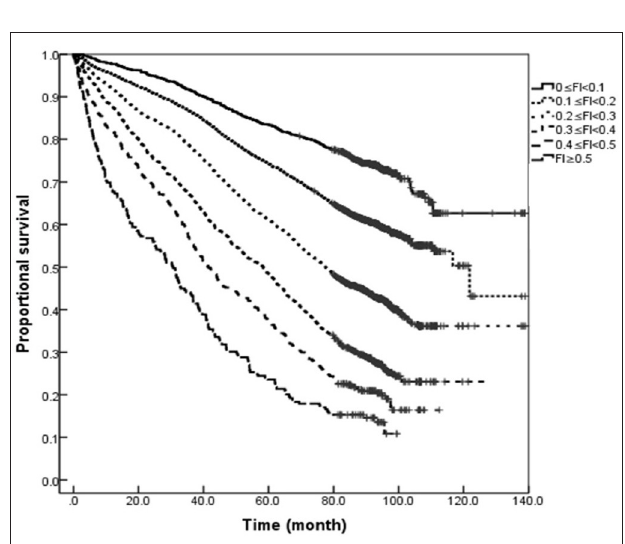
FIGURE 4 | Kaplan–Meier curves for the proportional survival of older women with different degrees of